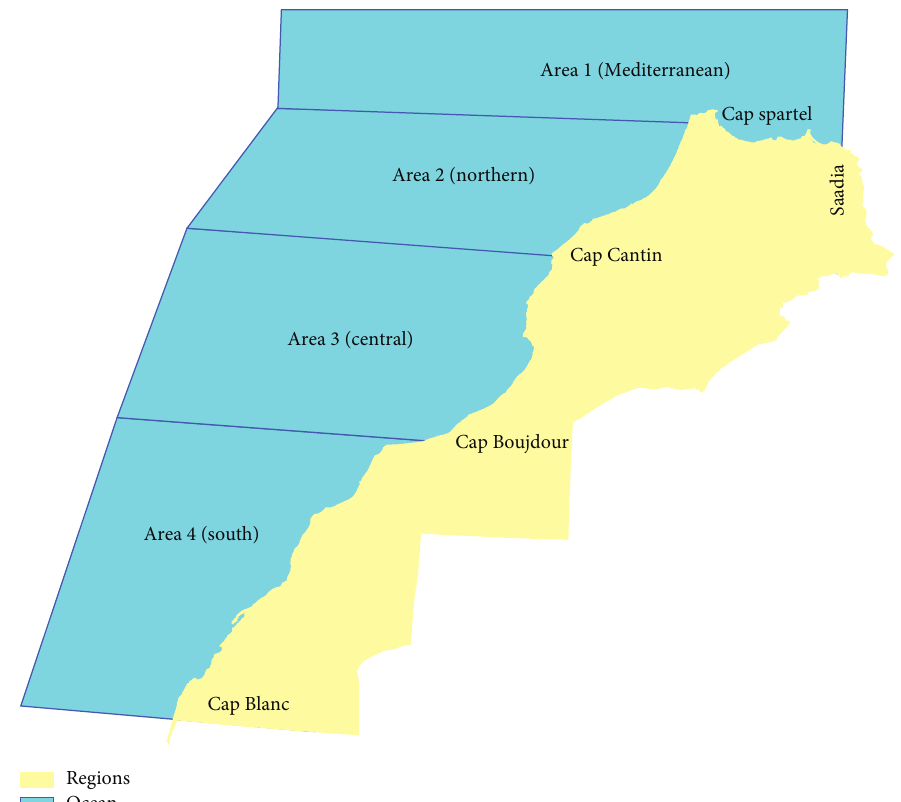
Figure 2: The Atlantic coasts of Morocco are characterized by their richness and biological diversity. Morocco’s exclusive area is characterized by great diversity of fishery resources. There are four fishing areas in Morocco whose relative importance in terms of activity has undergone a great change over time. The first, area 1 is the Mediterranean area between Saadia and Cap Spartel, the second, area 2 is the northern area between Cap Spartel and Cap Cantin, the third, area 3 is the center area between Cap Cantin and Cap Boujdour, and latest one, area 4 is the area between Cap Boujdour and Cap